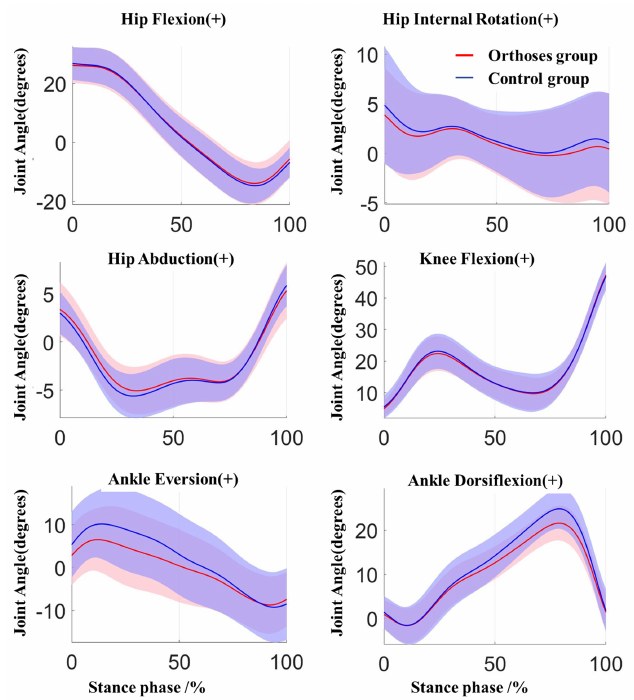
Figure 4. Joint kinematics of the lower limb in the orthoses group (red) and control group (blue) during stance phase. Shaded area±1 std.